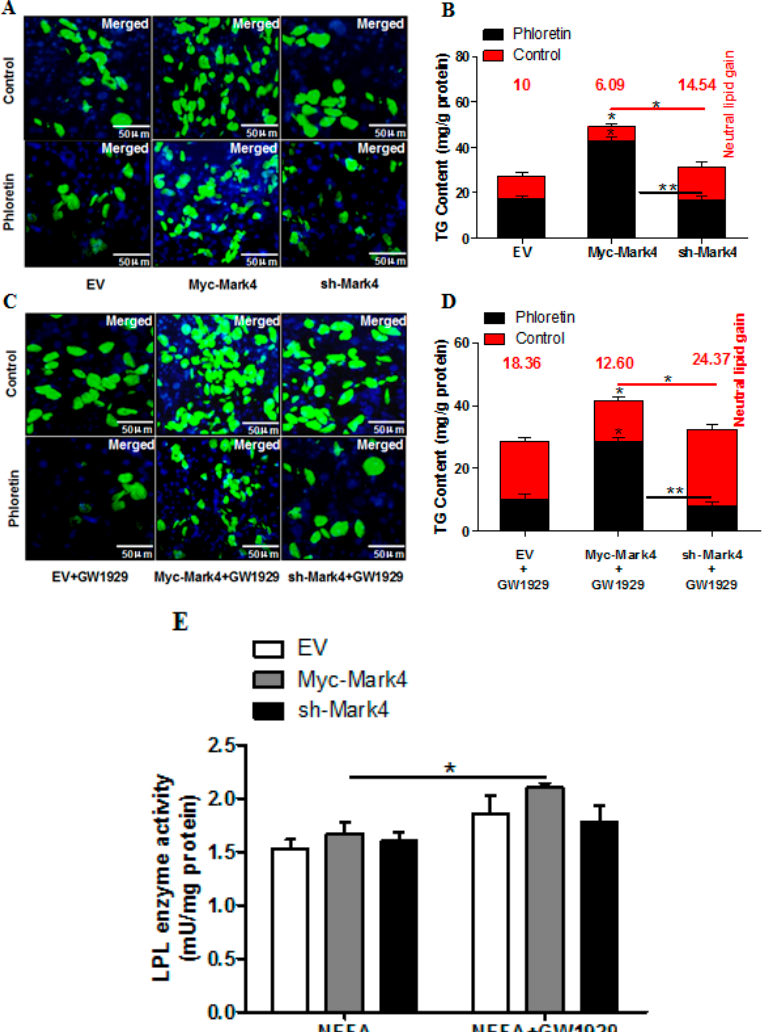
Figure 2. MARK4 promotes lipid accumulation in pig primary trophoblast cells challenged with 400 µ M NEFA. (A and C) Representative images (100 × ) of Bodipy staining after transfection with Myc-MARK4, sh-MARK4 for 48 h in primary (trophoblast cells) isolated from pig placentas. Primary trophoblasts were then incubated with 400 µ M NEFA, 2 µ M GW1929 or 500 µ M phloretin for 24 h ( n = 3). ( B and D ) Quantification of corresponding triglyceride (TG) in ( A ) and ( C ) by ELISA analysis ( n = 3). The values in red indicate receptor (transport proteins)-mediated fatty acid accumulation by subtracting the values in the presence of phloretin from those in the absence of phloretin. (E) LPL activity (mU/mg protein) after transfection with Myc-MARK4, sh-MARK4 for 48 h in pig primary trophoblasts. Cells were then treated with 400 µ M NEFA or 2 µ M GW1929 for 24 h ( n = 3). Values are expressed as mean ± SEM. ** p < 0.01; * p < 0.05 compared with the control group. Myc-MARK4 group: overexpression of MARK4 group, sh-MARK4 group: knock down of MARK4 group, Control: empty vector (EV) group.